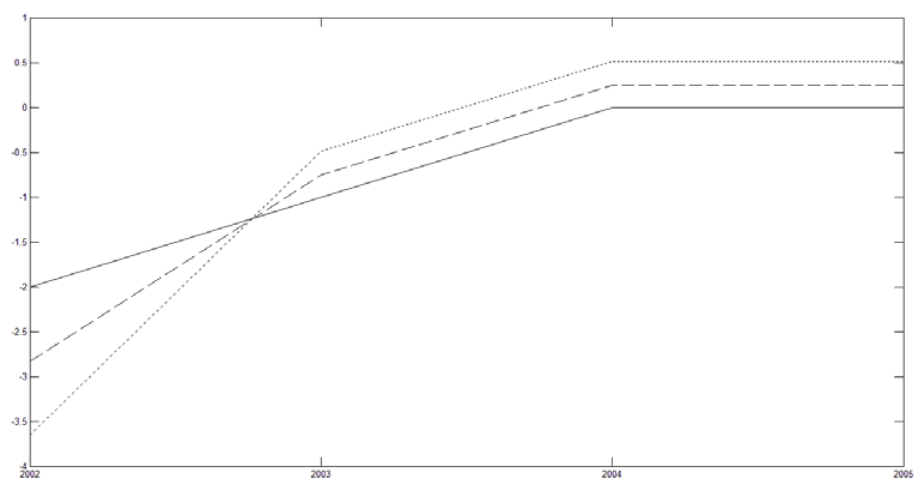
Figure 3. Constant additive